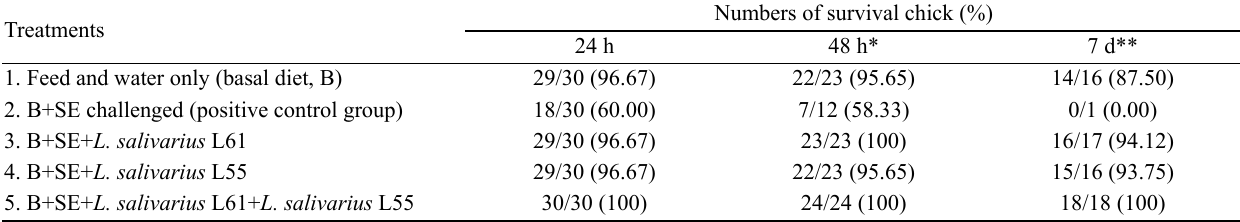
Table 1. Number of surviving chicks after Salmonella Enteritidis (SE) challenge and fed Lactobacillus in posthatch chicks